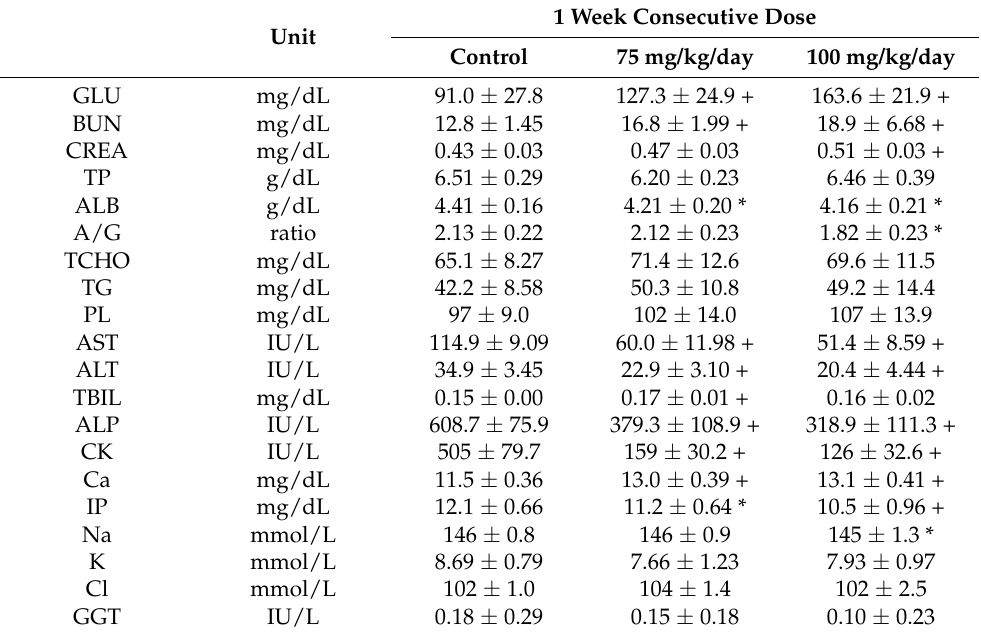
Table 4. Serum biochemical parameters obtained on 1-week consecutive ifosfamide-administered rats.